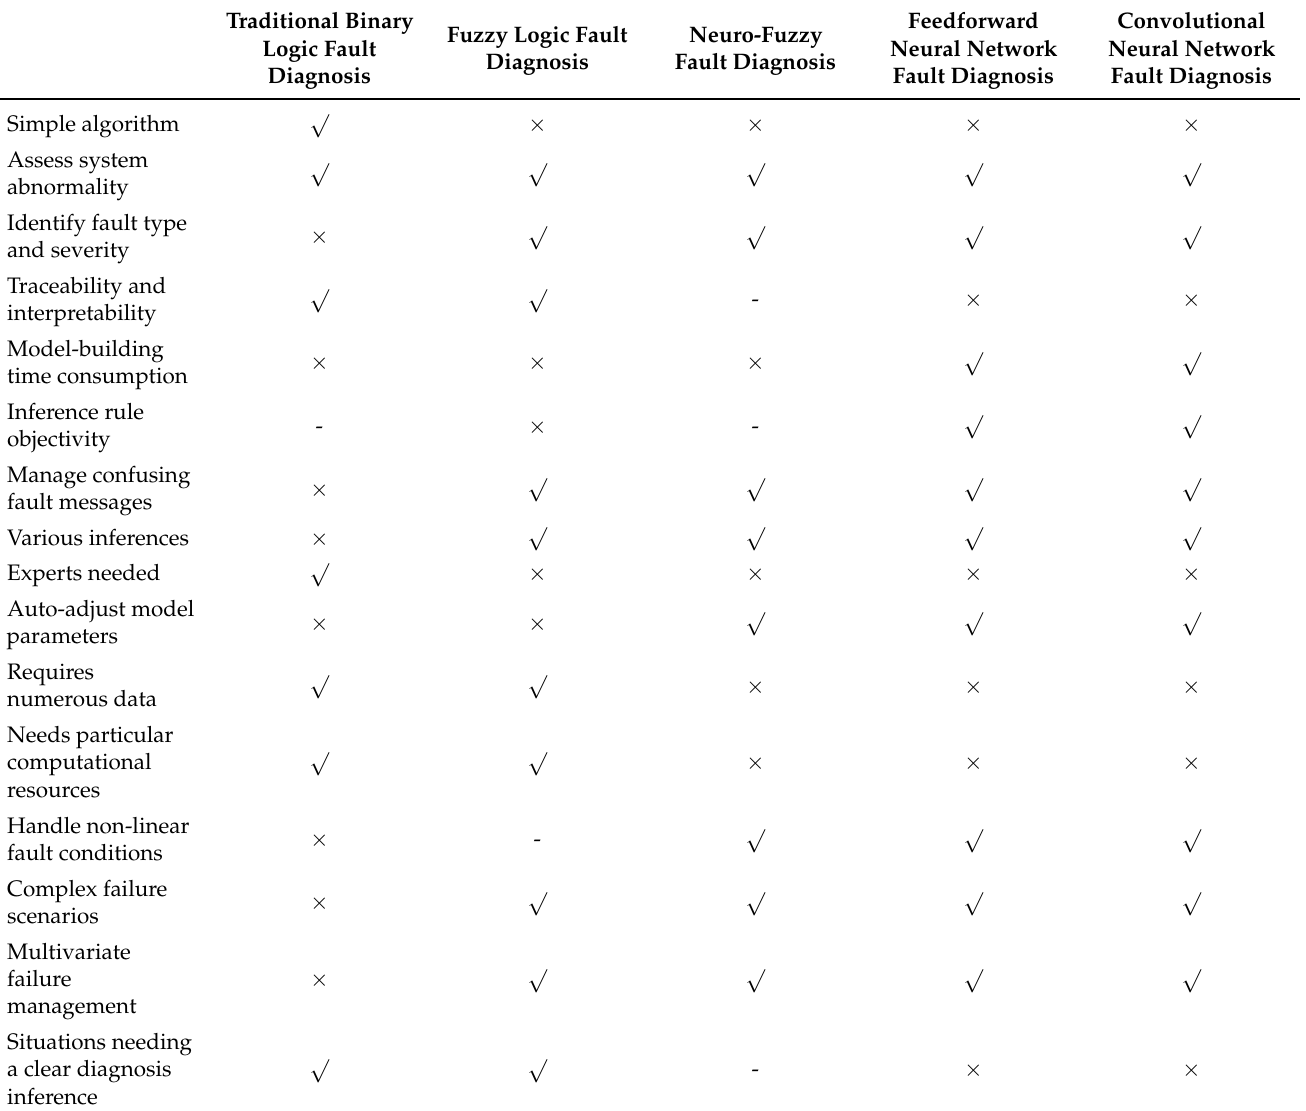
Table 2. Evaluation of sixteen features of five fault diagnosis methods (” this approach in this characteristic, ” × ” denotes a drawback of this approach in this feature, and ”-” sign denotes a combination of benefits and disadvantages in this aspect for this